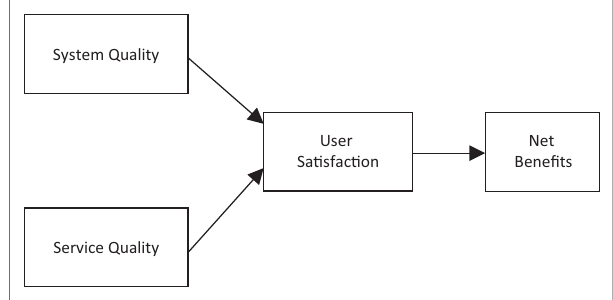
FIGURE 3: Business Intelligence System success